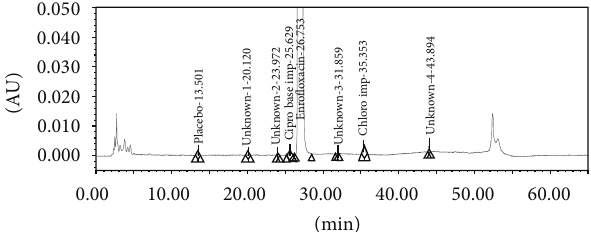
Figure 6: Placebo at 254 nm.